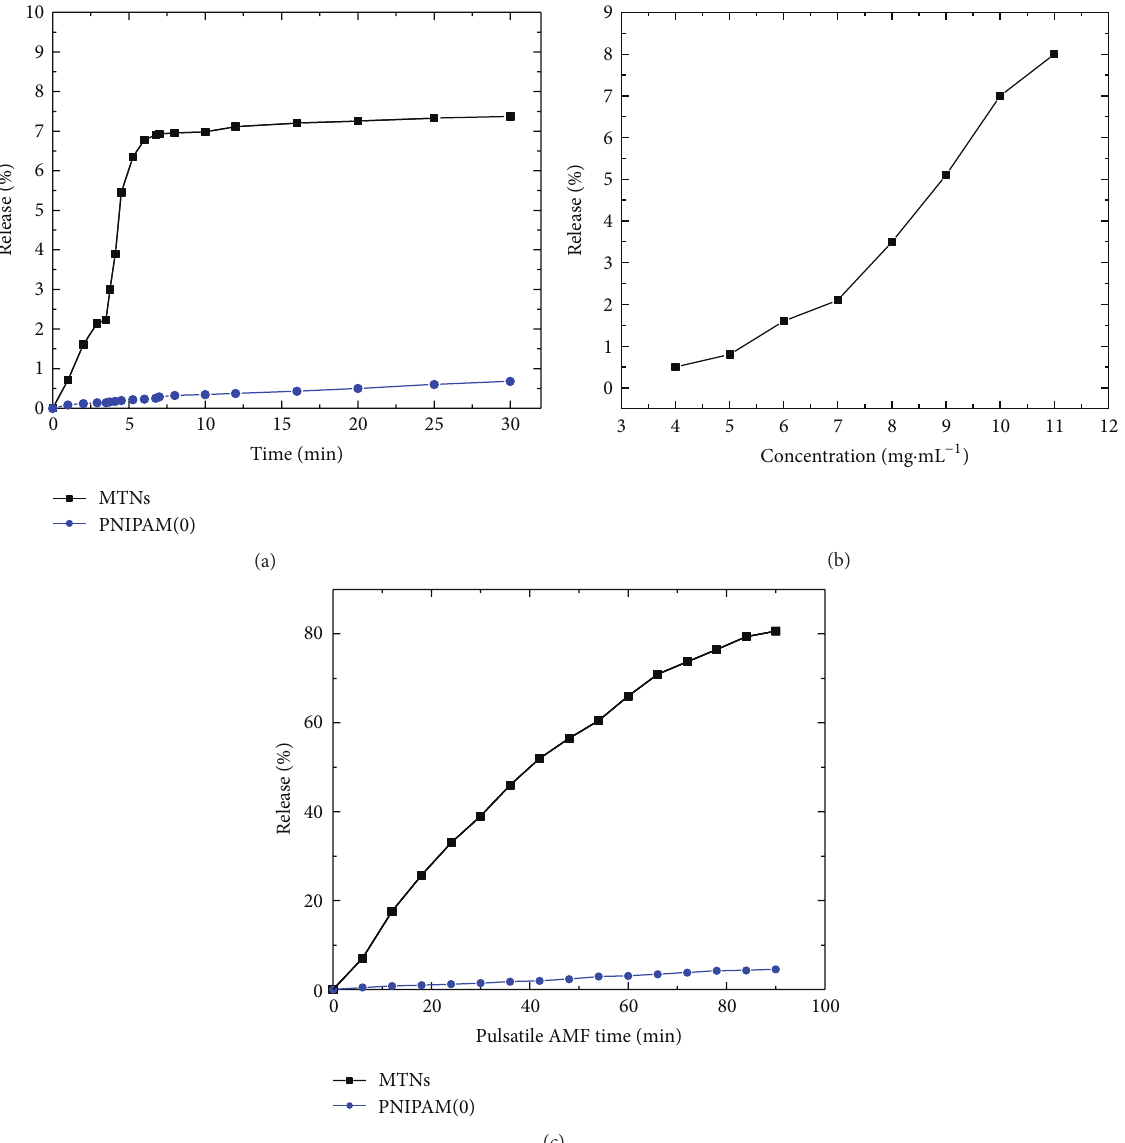
Figure 5: (a) Release rate of Rh(B) from MTNs and PNIPAM(0) when an AMF is applied continuously for 30 minutes. (b) Effect of iron oxide nanobeads (NBs) concentration on the release rate of Rh(B) after applying magnetic stimuli for 7 minutes. (c) Pulsatile release of Rh(B) from MTNs and PNIPAM(0) by consecutively applying an alternating magnetic field (AMF) for 6 minutes separated by 5-minute intervals without magnetic